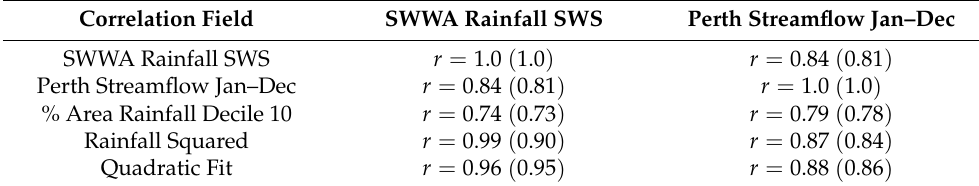
Table 2. Correlations ( r ) between SWWA rainfall, PARD10, streamflow into Perth dams (as in Table 1), rainfall squared and a quadratic fit of rainfall to streamflow with detrended correlations in brackets. The confidence levels ( C L ) of the correlations are greater than 99% in all